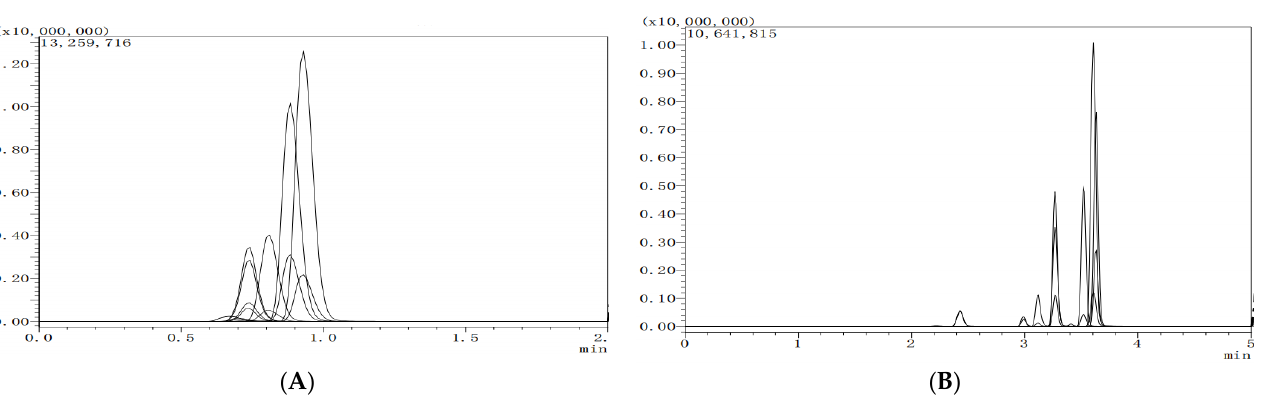
Figure 3. The chromatogram of eight targeted compounds separated by the constant elution ( A ) and gradient elution, ( B ) of mobile phase (lateral axis is time, and longitudinal axis is response